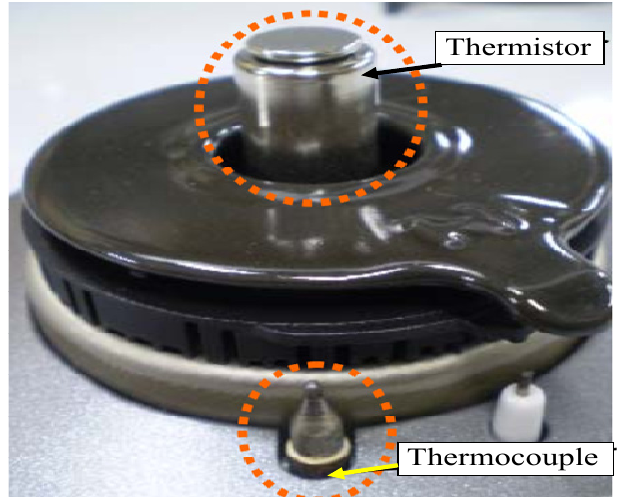
Figure 2. The photo of the SI sensors [22].